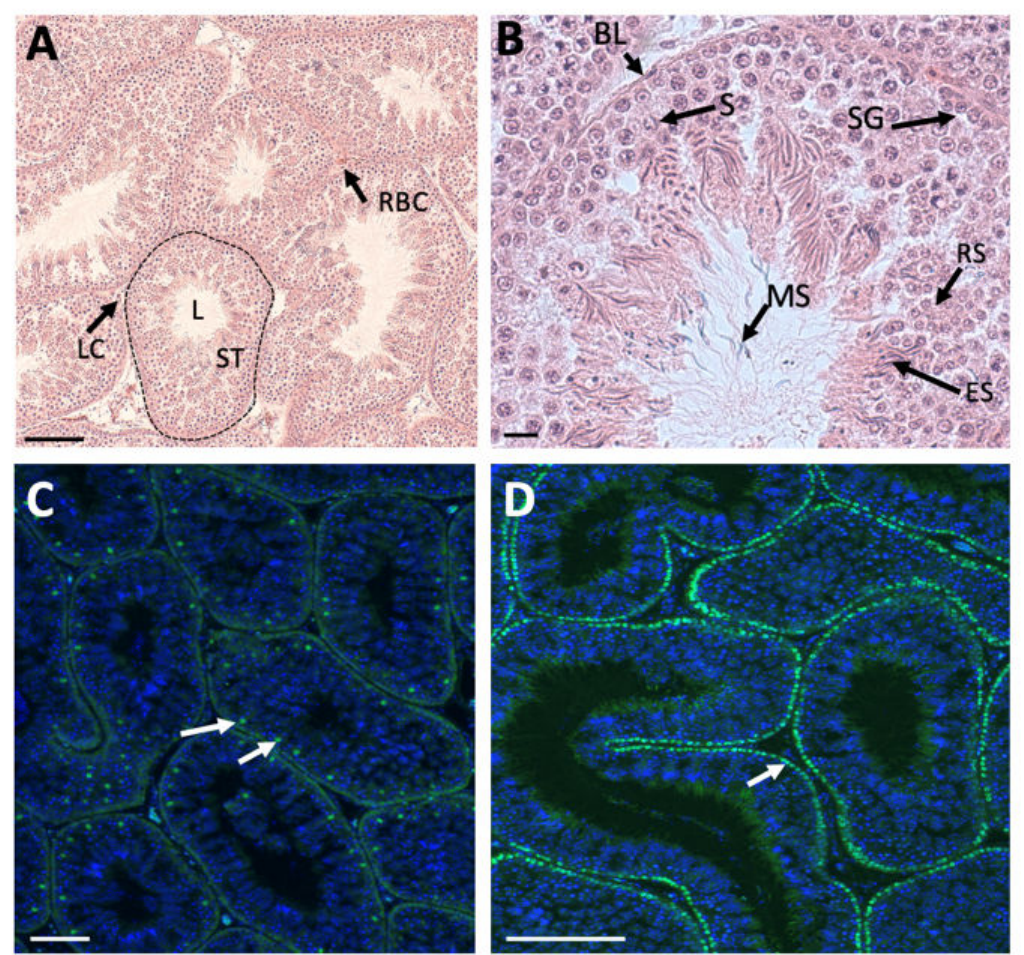
Figure 1. Histology and immunofluorescence of adult chicken testis. ( A ). Haematoxylin and eosin staining, showing seminiferous tubules (example: ST, dotted outline) and clusters of Leydig cells (example: LC). Red blood cells (RBC) are present between tubules. L, lumen of tubule. Scale bar = 100 µ m. ( B ). High magnification view of adult testis tubule, showing Sertoli cells (example, S) and stages of spermatogenesis (example: SG, spermatogonia; RS, round spermatids; ES, elongated spermatids; BL, basal lamina; MS, mature spermatozoa). Scale bar = 10 µ m. ( C ). Immunofluorescent localization of SOX9 (green) in the Sertoli cell nuclei of seminiferous tubules (example; white arrows). DAPI counterstain. Scale bar = 100 µ m. ( D ). Immunofluorescent localization of DMRT1 in the nuclei of spermatogonia and Sertoli cells (green), aligned along the basal lamina of the seminiferous tubule (example, white arrow). DAPI counterstain. Scale bar = 100 µ